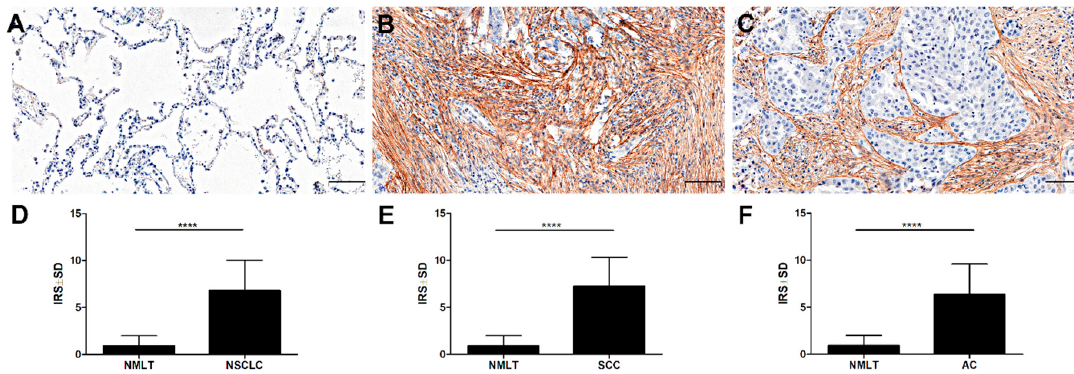
Figure 4. Expression of periostin (POSTN) in ( A ) non-malignant lung tissue (NMLT), ( B ) squamous cell cancer (SCC), and ( C ) adenocarcinoma (AC). Immunohistochemical evaluation of periostin (POSTN) expression level in ( D ) non-small cell lung carcinoma (NSCLC), ( E ) squamous cell cancer (SCC), and ( F ) adenocarcinoma (AC) compared to non-malignant lung tissue (NMLT), (**** p < 0.0001); Mann–Whitney U test. Magnification 200×. Bar = 100 µm.